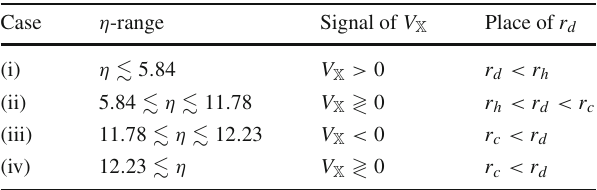
Table 3 Different regions for the potential in RNdS, for Q = 0 . 86 > Q c (and M = (cid:2)/ 2 = ( L / 6 ) 2 = 1; m 2 = 0)